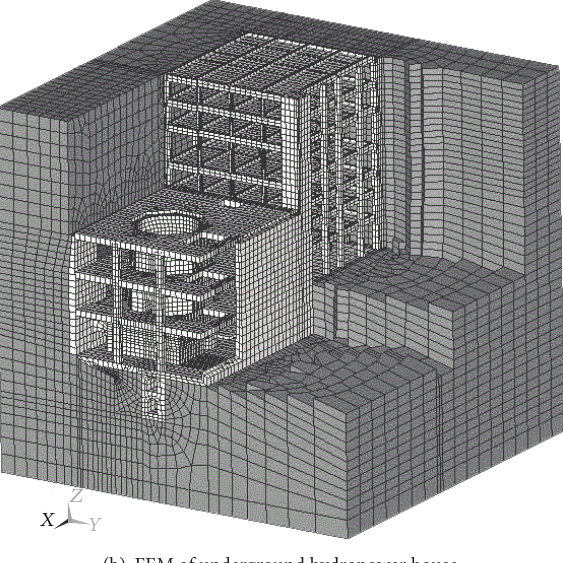
Figure 1: Profile View and the FEM of underground hydropower